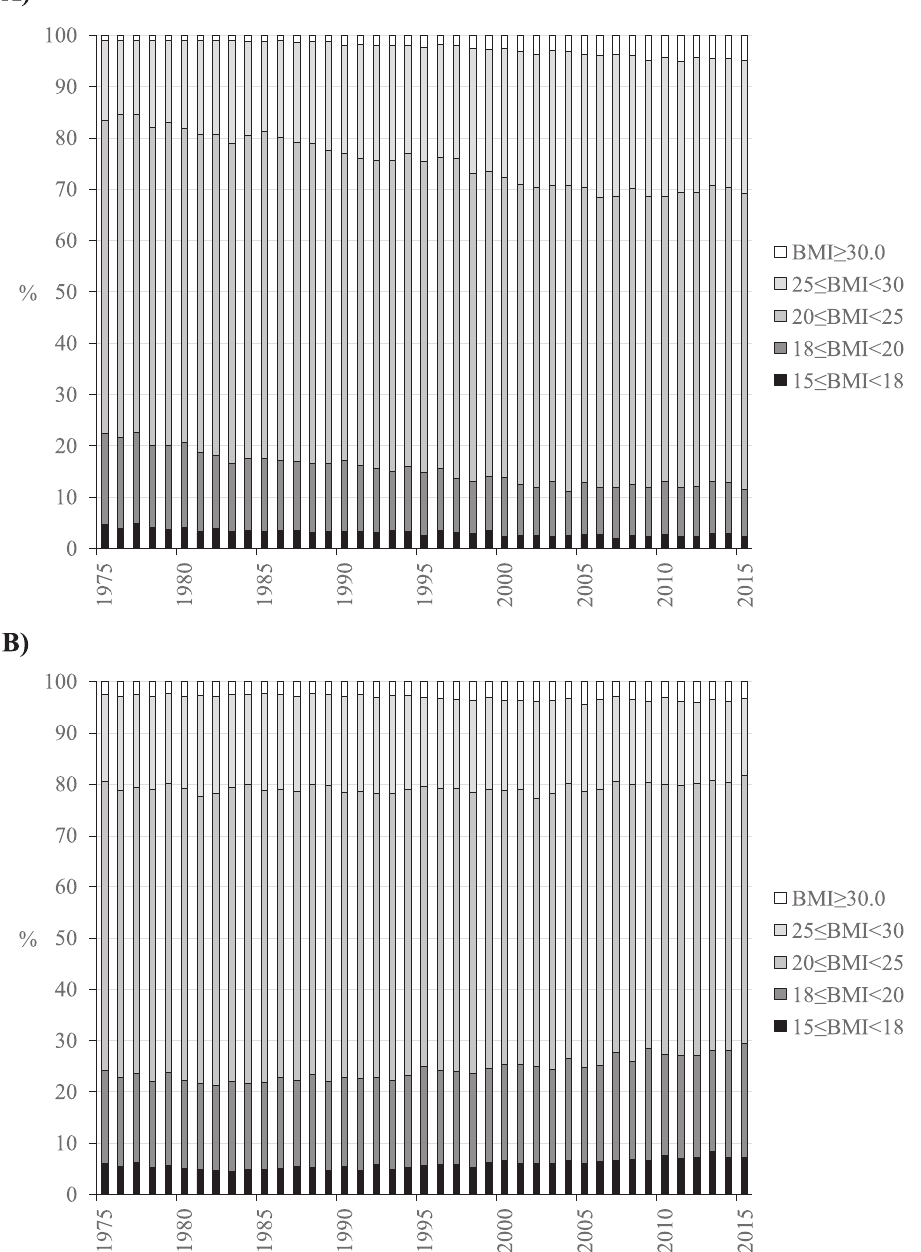
Figure 1. Distribution of BMI in Japanese (A) men and (B) women aged 20 to 74 years, 1975 to 2015. BMI, body mass